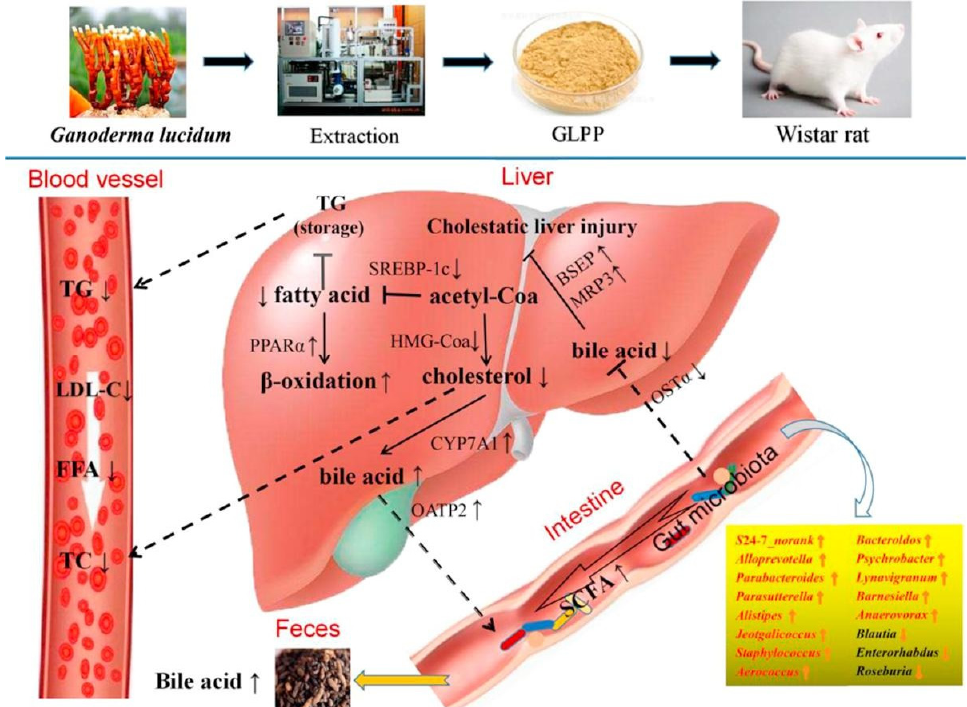
Figure 6. Regulatory mechanism of GLPP on hyperlipidaemia, hypercholesterolemia, and gut microbiota dysbiosis in rats fed on HFD. GLPP: Ganoderma lucidum polysaccharide peptide; HFD: high-fat diet; TG: triglyceride; TC: total cholesterol; LDL-C: low-density lipoprotein cholesterol; FFA: free fatty acids; SCFA: short-chain fatty acids; OST α : organic solute transporter alpha; CYP7A1: cholesterol 7 α -hydroxylase; SREBP-1C: sterol regulatory element-binding protein-1C; PPAR α : peroxisome proliferator-activated receptor alpha; HMG-Coa: 3-hydroxy-3-methylglutaryl coenzyme A; BSEP: bile salt export pump; MRP3: multidrug-resistance-associated protein 3; OATP2: organic-anion-transporting polypeptides 2. Source: Reprinted with permission from Lv et al. [226]. 2022, Elsevier.